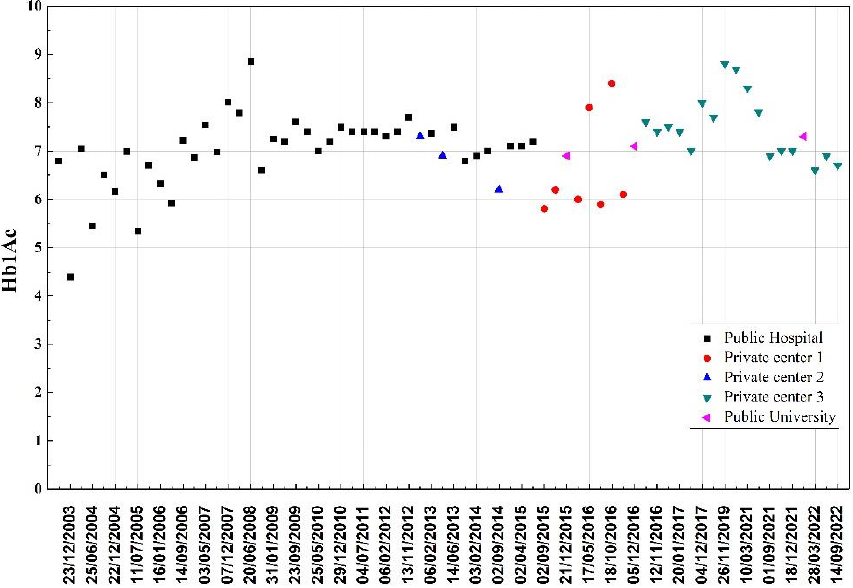
Figure 1. Evolution of the Hb1Ac values during the patient’s 21 years of insulin therapy.